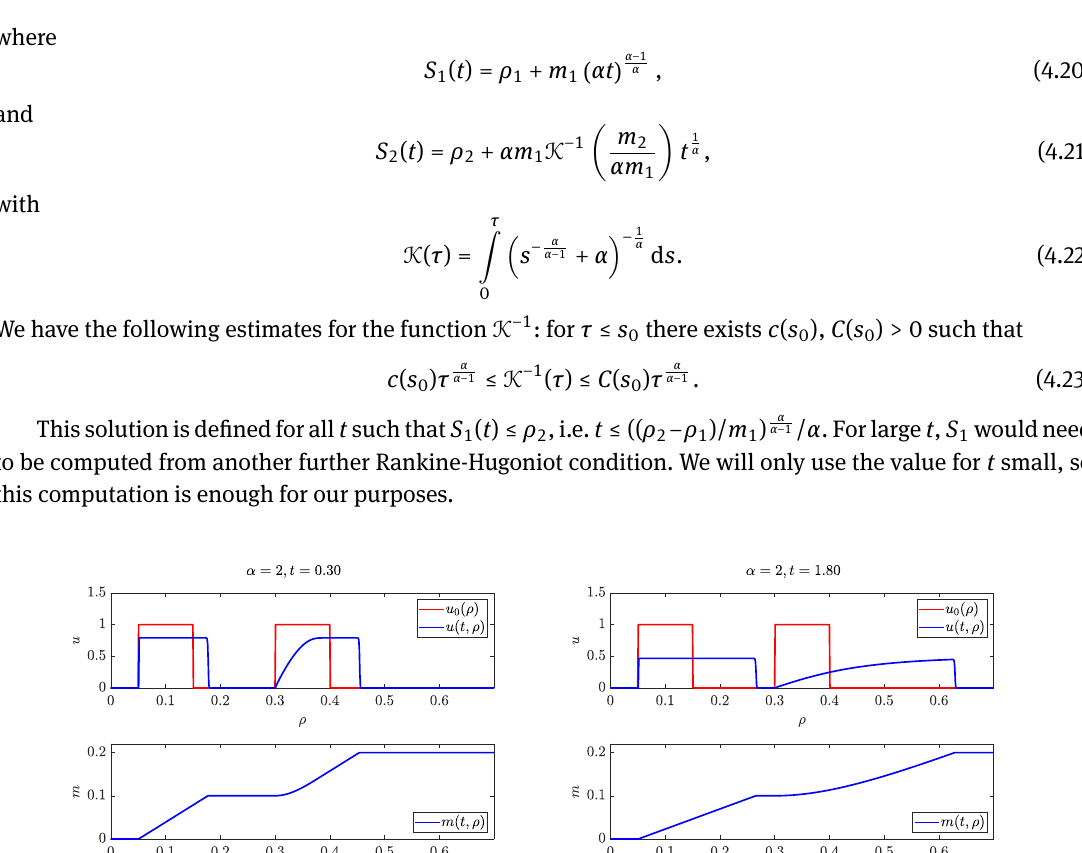
is recovered by numerical ρ